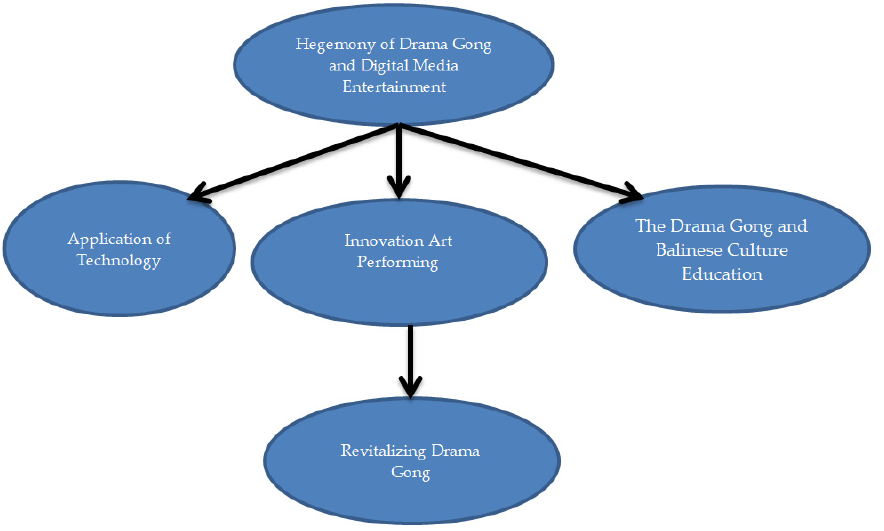
Figure 1. Conceptual Framework for the Innovation of the Performing Arts and Culture Drama Gong.